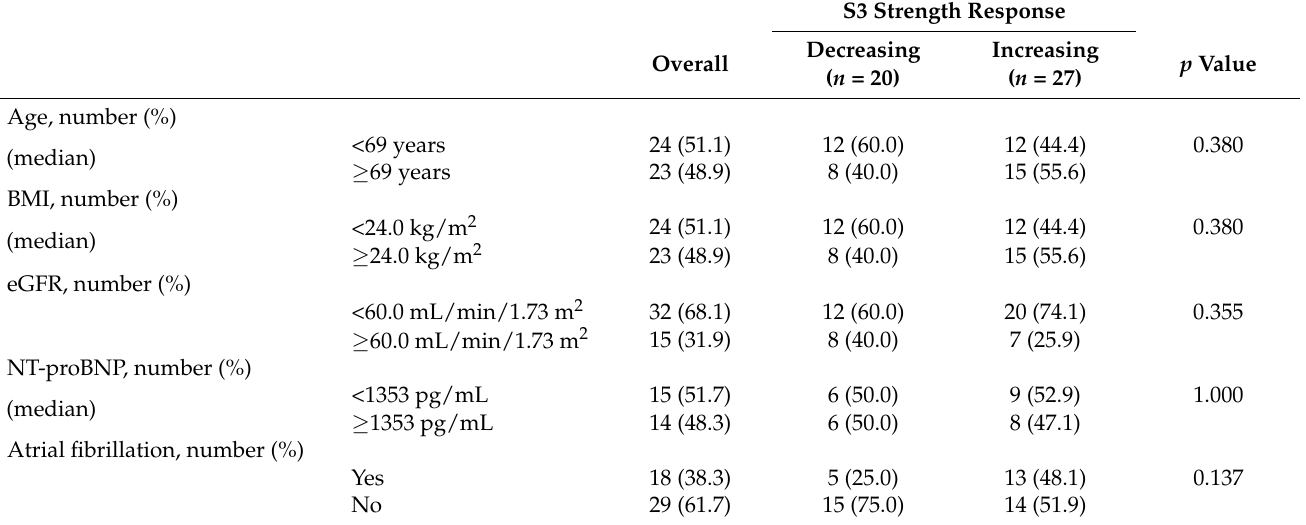
Table 5. Comparison of background characteristics with S3 Strength response to exercise-induced PAP